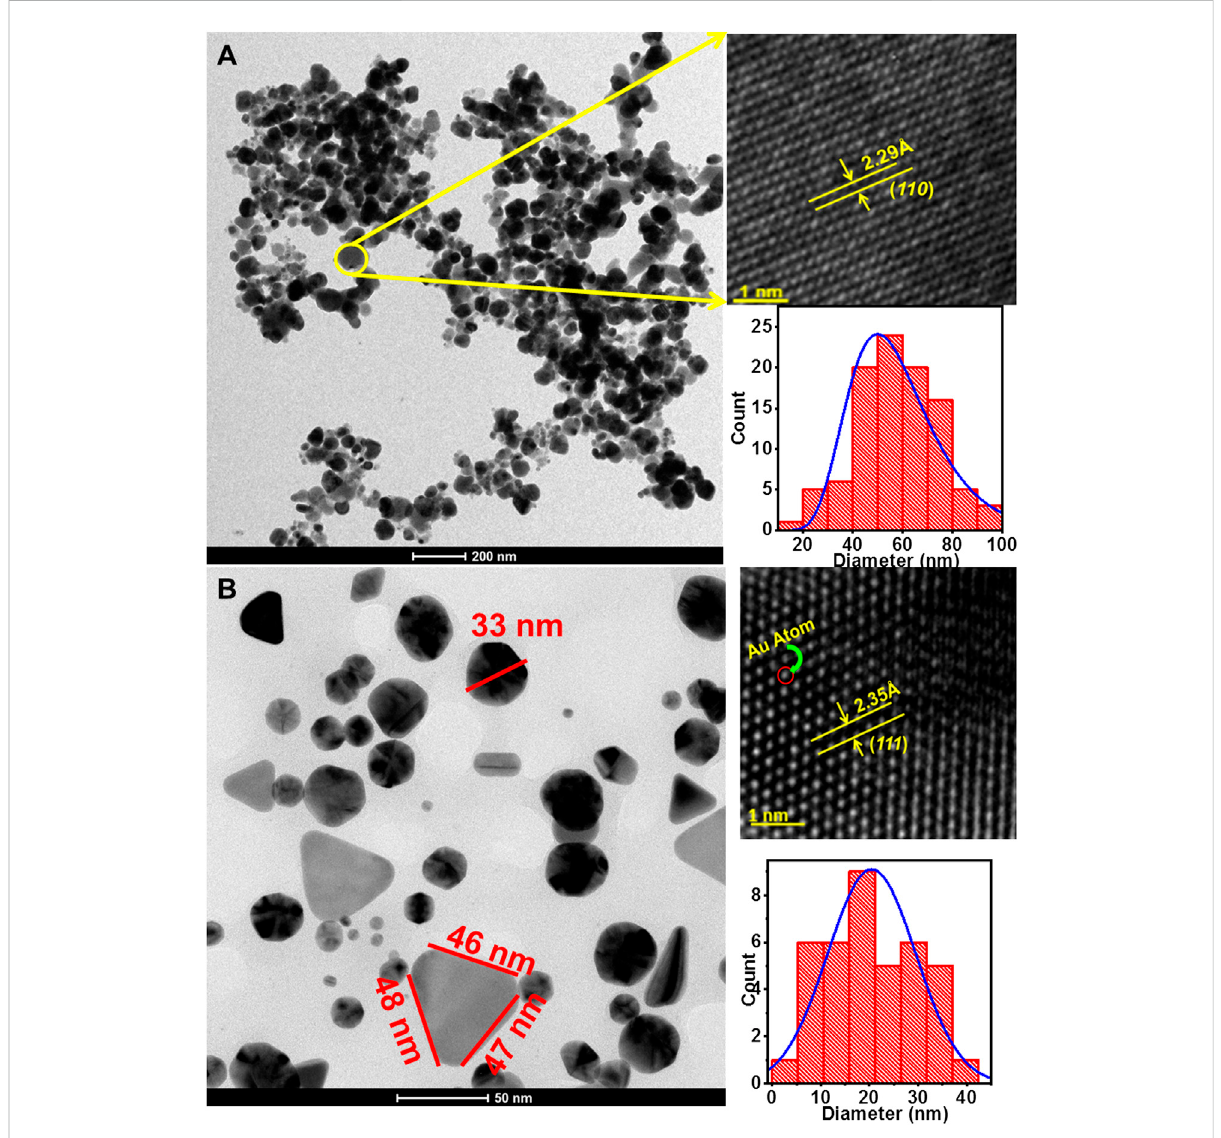
FIGURE 5 High-resolution transmission electron micrographs of nanoparticles synthesized by LFLE. (A) Spherical and irregular AgNPs synthesized by LFLE, (B) anisotropic AuNPssynthesizedby LFLE showing triangular, spherical, rod shaped and blunt ended hexagonal shapes; their upper and lower insets showing the magni fi ed HRTEM image and histogram plot of the particle distribution,